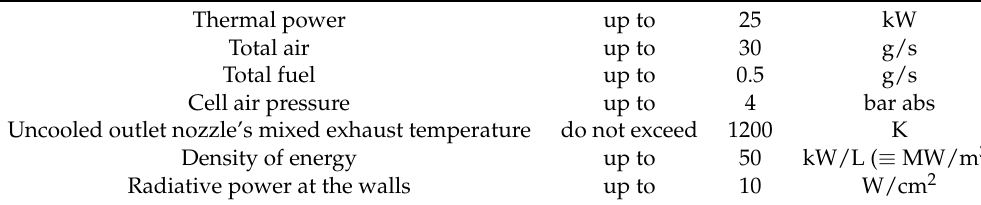
Table 2. Performance of the emootion high-pressure and -temperature combustor rig.